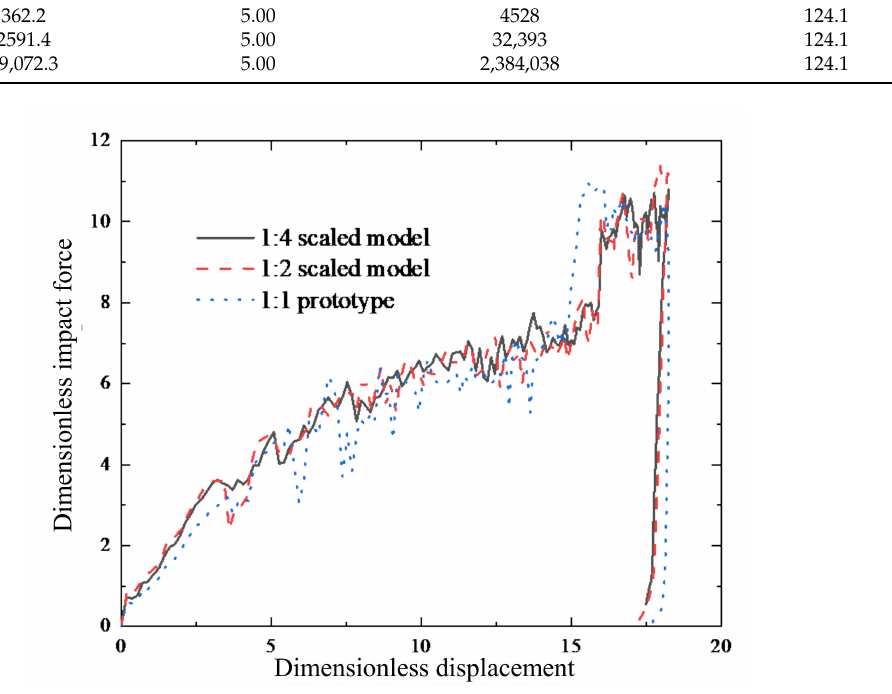
Figure 12. Comparison of dimensionless force-displacement curves under the same dimensionless impact